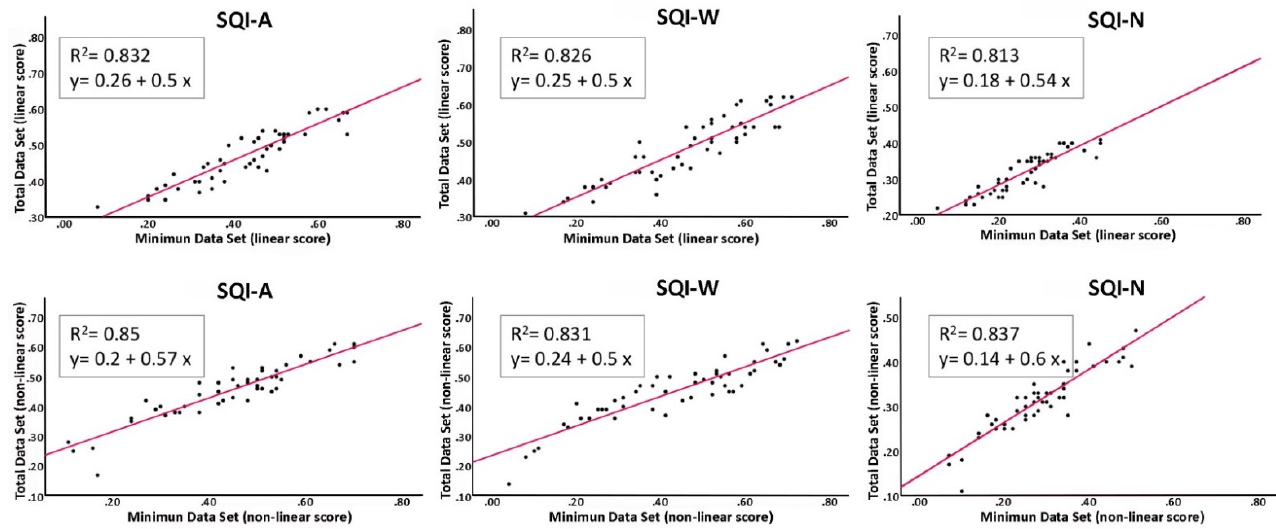
Figure 6. Linear relationships between SQIs (SQI-A, SQI-W and SQI-N) are calculated using the (TDS) and (MDS) approaches, and the linear (first line) and nonlinear (second line) scoring methods. The lowest coefficient (R = 0.81) results from the use of the TDS and MDS-L-N models (Nemoro and linear